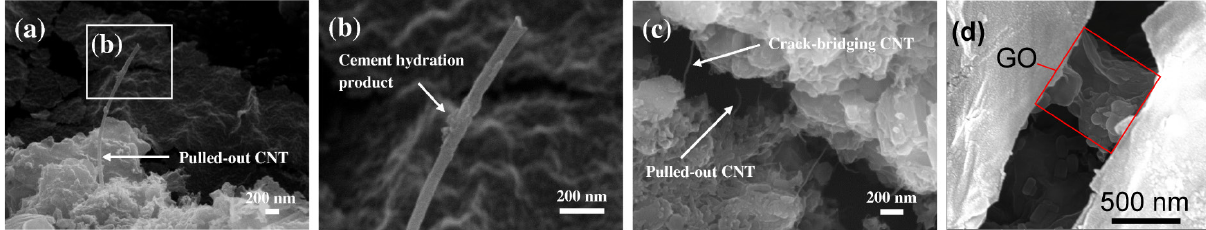
Figure 11: (a)-(c) The pull-out behavior and crack-bridging roles of CNTs in cement [72]; (d) GO sheets trapped in a nanoscale crack in ce- ment [120]